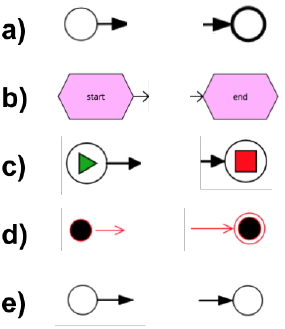
Figure 3. Start and end events (without a specific type) in various process representations: ( a ) BPMN, ( b ) EPC, ( c ) YAWL, ( d ) UML AD, ( e ) Petri